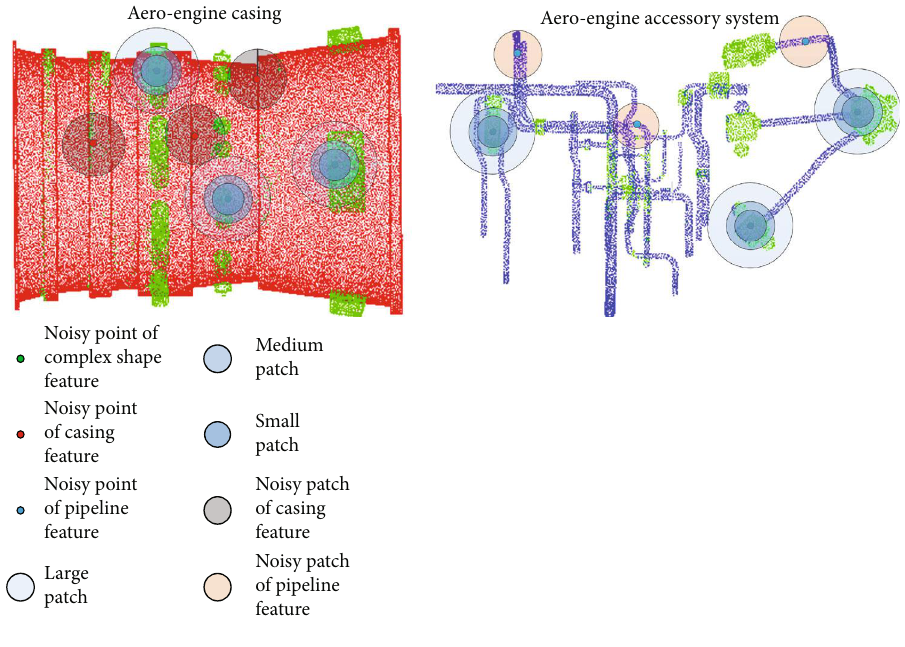
Figure 18: The patches of di ff erent structural